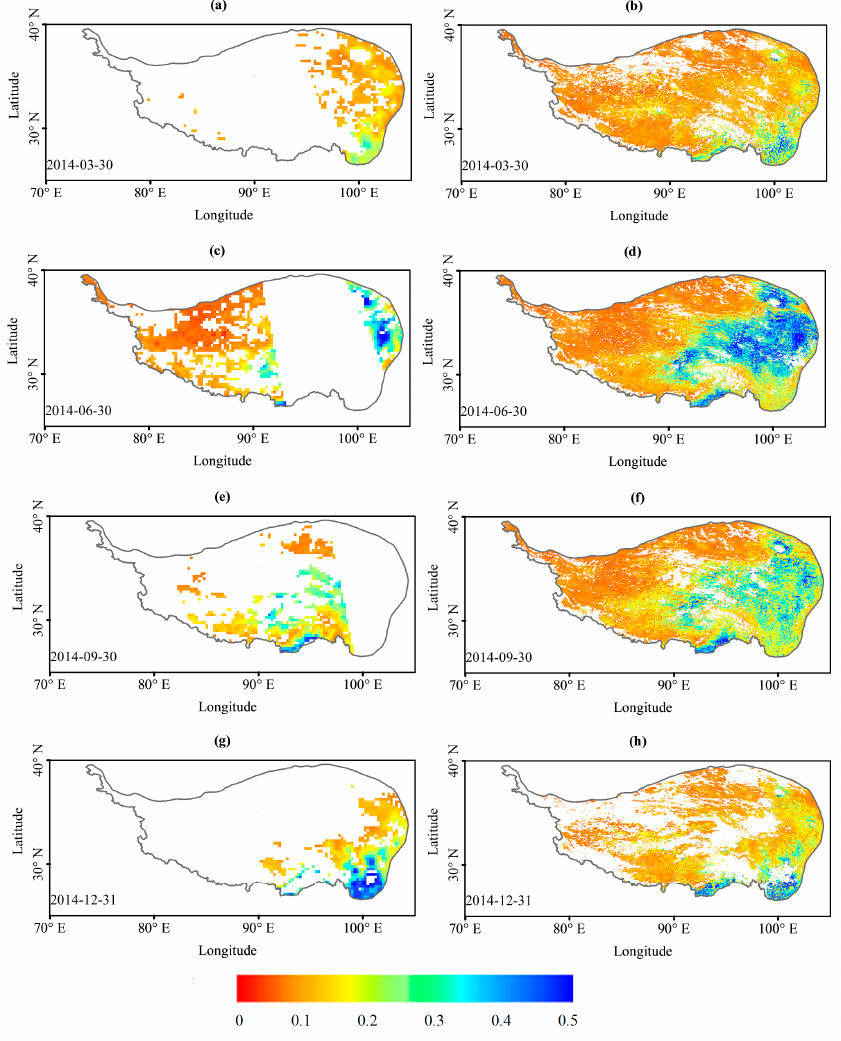
Figure 4. Maps of Fengyun original soil moisture (FY_Ori SM, left column: ( a , c , e , g )), and corresponding resolution-improved soil moisture (FY_Imp SM, right column: ( b , d , f , h )) on 30/03, 30/06, 30/09, 31/12, over the Tibetan Plateau. Units: cm 3 cm -3 .